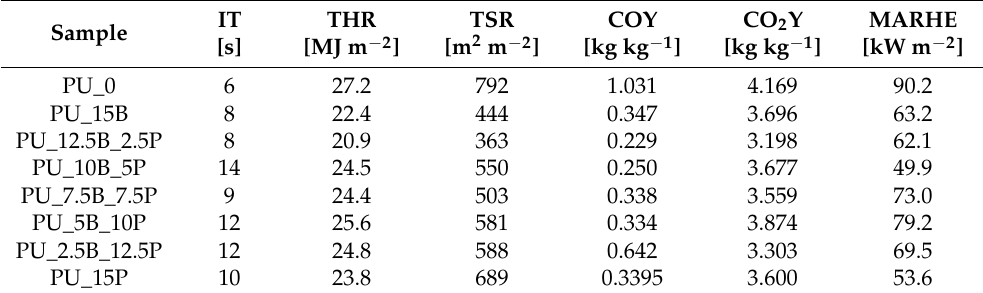
Table 5. Burning behavior parameters of composite polyurethane